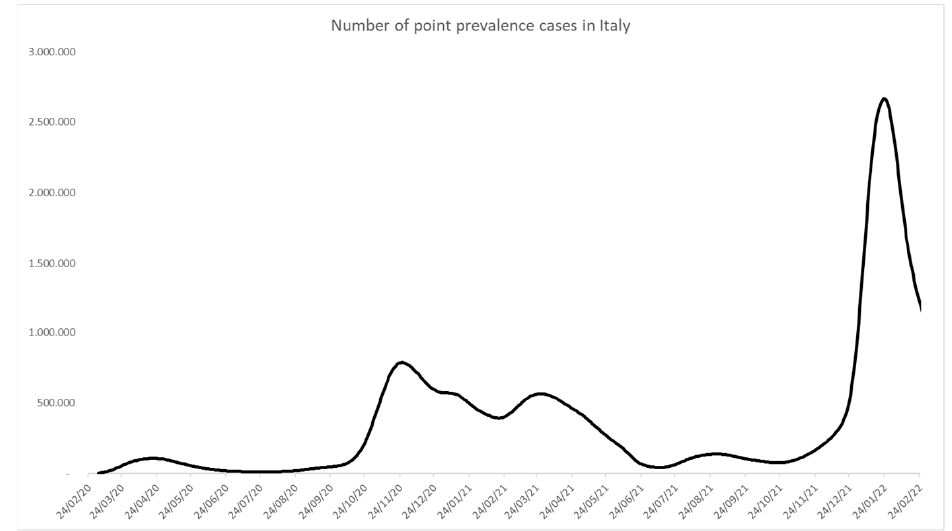
Figure 1. The number of cases in Italy and epidemic waves. This figure was created by elaborating on raw data from ISS [10].